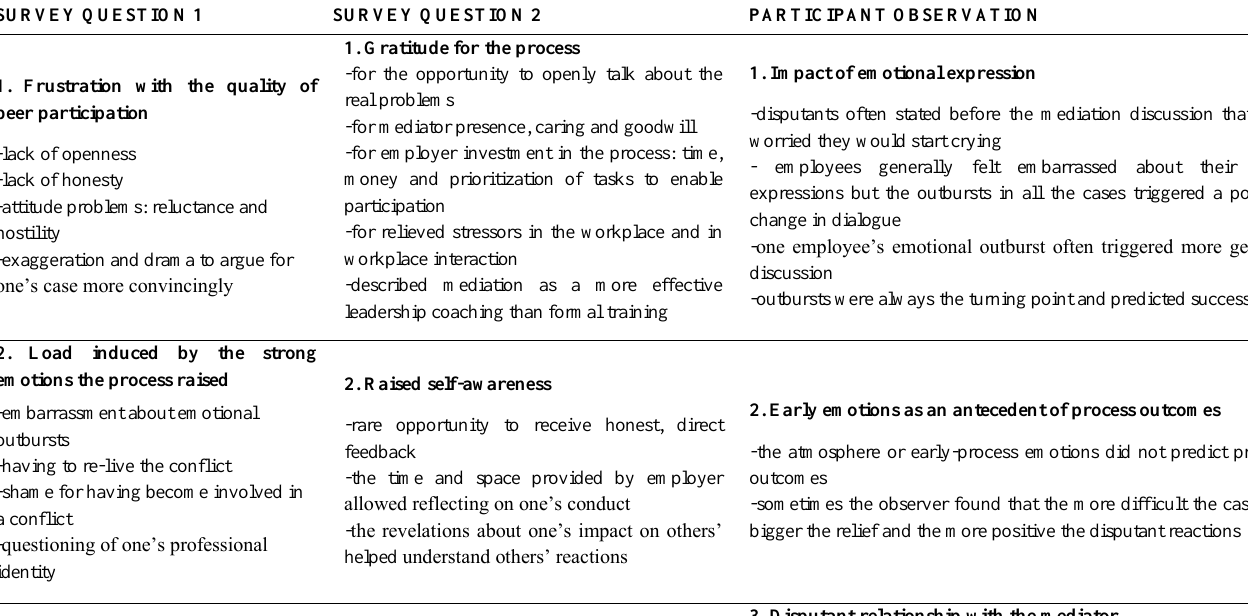
Table 1. The content themes yielded in the empirical